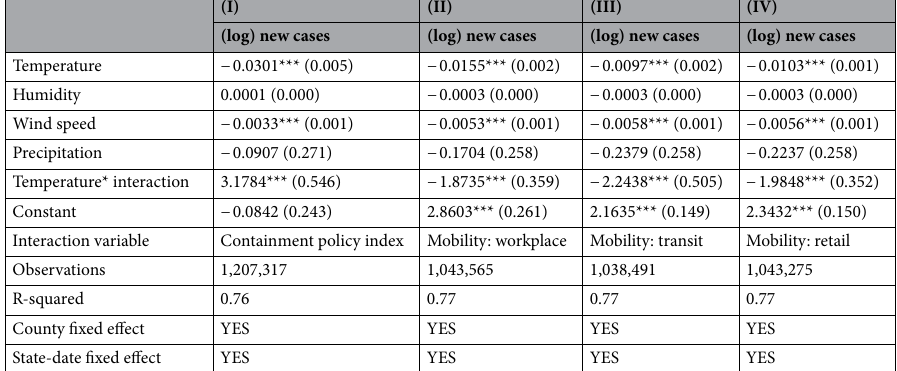
Table 3. The effect of temperature at t-7 (at 12:00 local time) on different new cases mediated by containment policy and physical mobility. The outcome variable is (log) new cases. Column I includes the (standardized) interaction term between temperature and the containment health policy index provided by the Oxford Government Tracker; columns II–VI include (standardized) interaction terms between temperature and mobility indices provided Google. Standard deviations based on robust standard errors clustered at the county level in parentheses. ***,**,*Significance at 1, 5 and 10%, respectively; N =